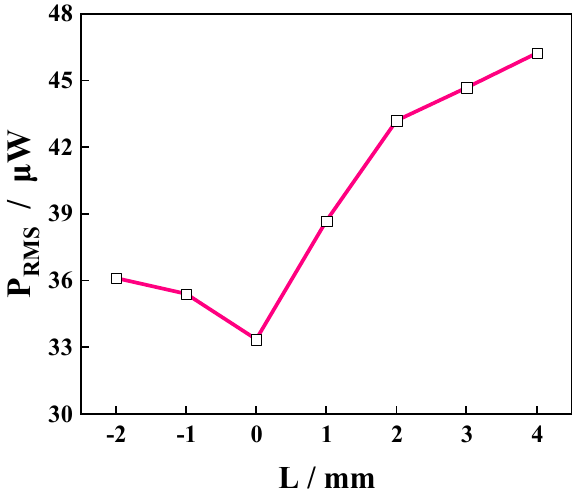
Figure 13. The effect of the rope margin on the PVEH output characteristics.